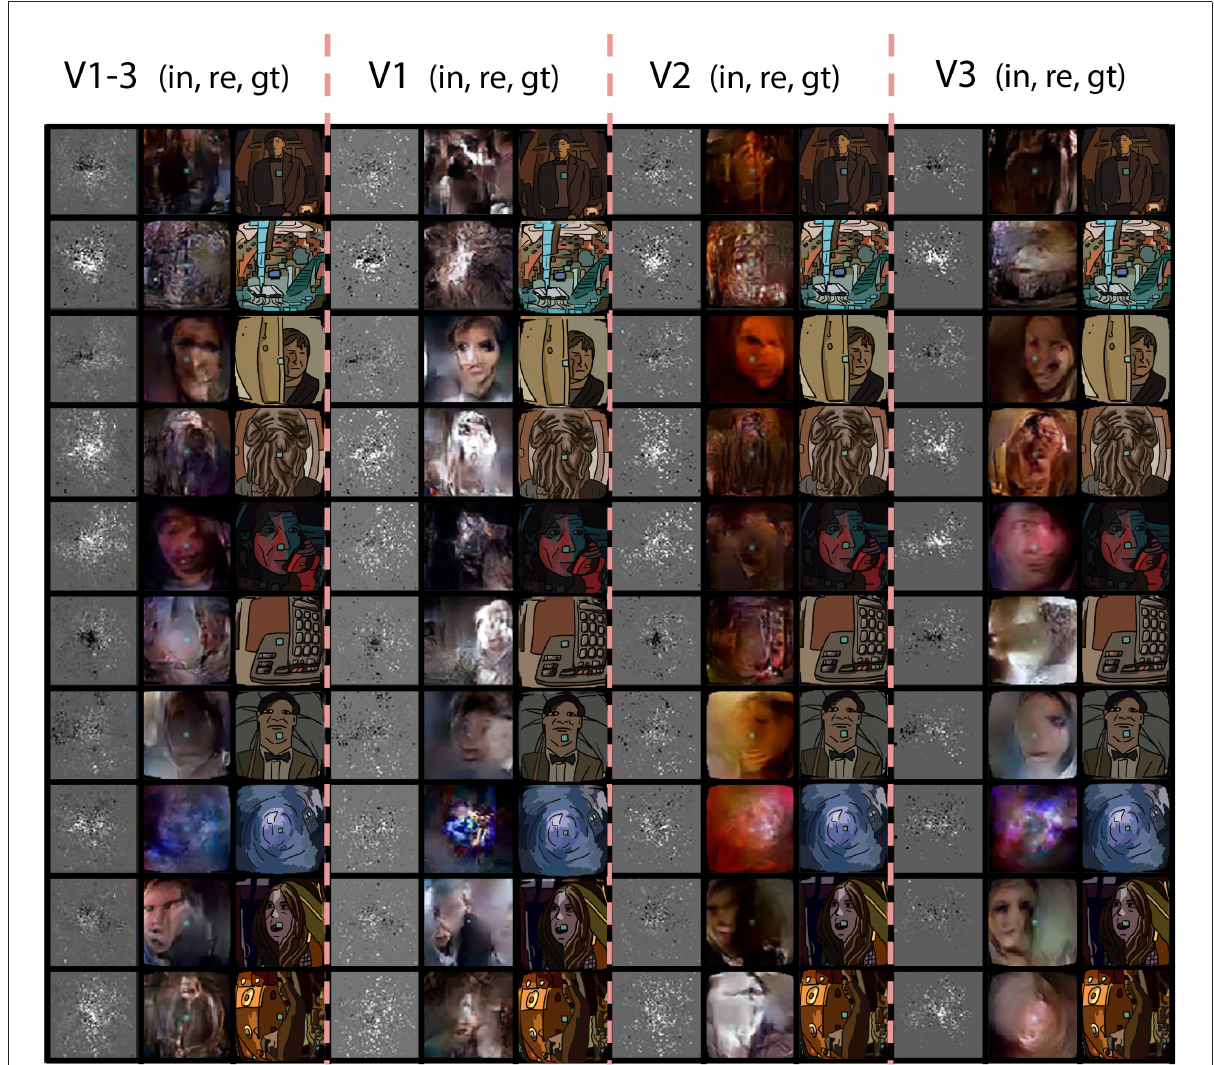
FIGURE5 ROI experiment. Reconstructions from the brain2pix FixedRF method trained on various brain regions. Columns 1–3 show the inputs (in), reconstructions (re), and ground truths (gt) of all combined regions (V1–V3), respectively. Columns 4–6 show these results for only V1, columns 7–9 for V2, and finally columns 10–12 are results belonging to t he model trained only on